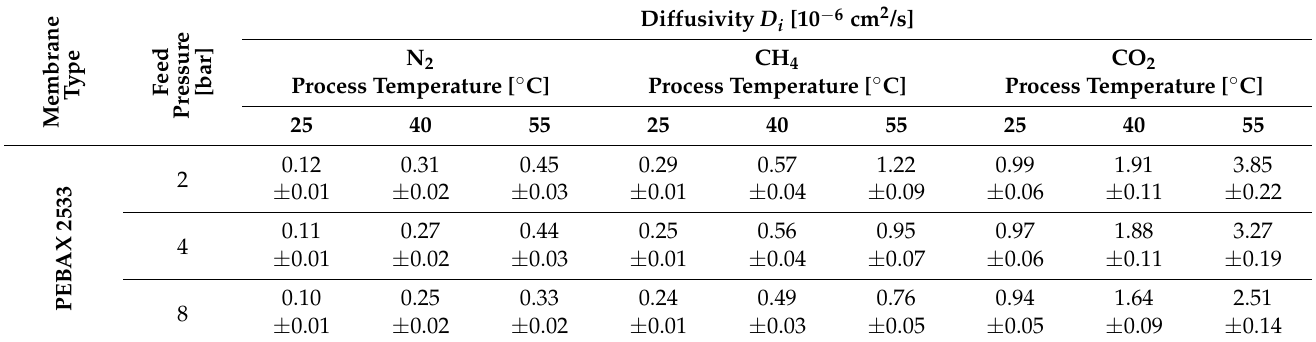
Table A5. Diffusion coefficient of homogeneous membranes to different gases measured for different feed pressure and temperature